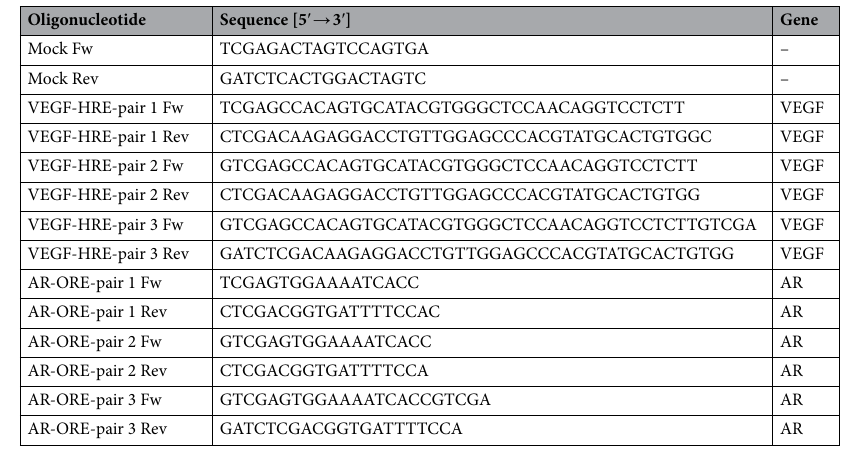
Table 2. Oligonucleotide sequences for molecular